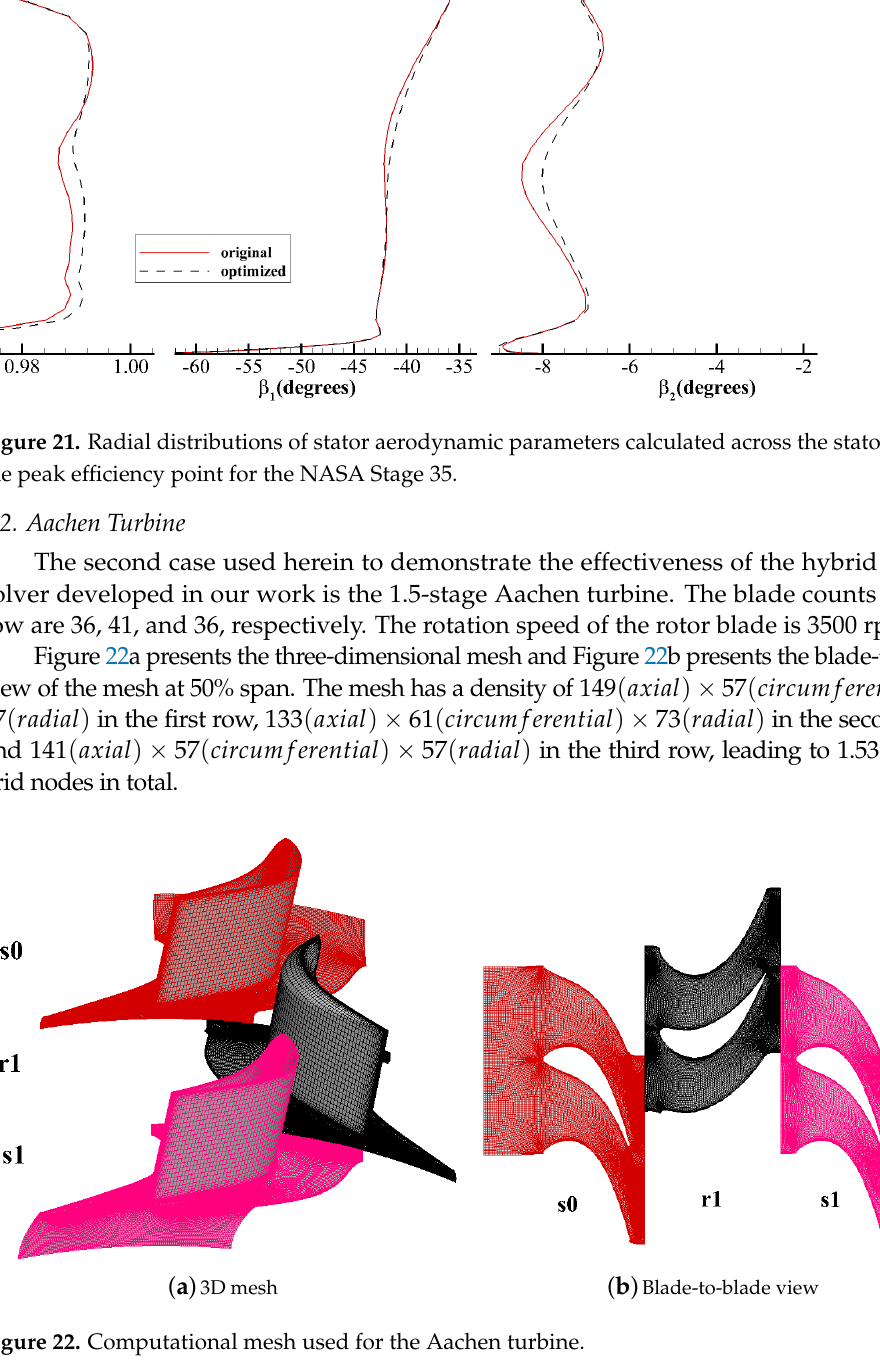
Figure 22. Computational mesh used for the Aachen